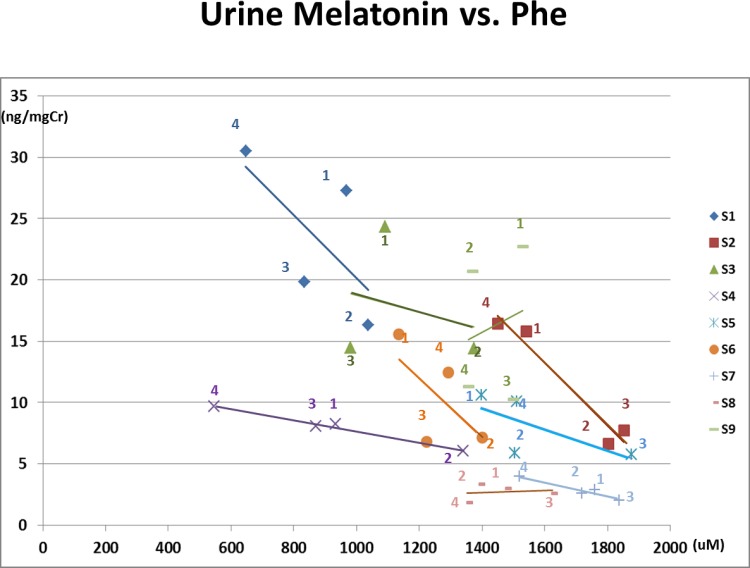
Urine 6-Sulfatoxymelatonin vs. Plasma Phenylalanine.The number of each data point indicates the study phase. Negative correlations with plasma phenylalanine concentrations and urine 6-sulfatoxymelatonin (p = 0.04) is shown. Except for S8 and S9, a linear negative regression line is drawn for each subject.